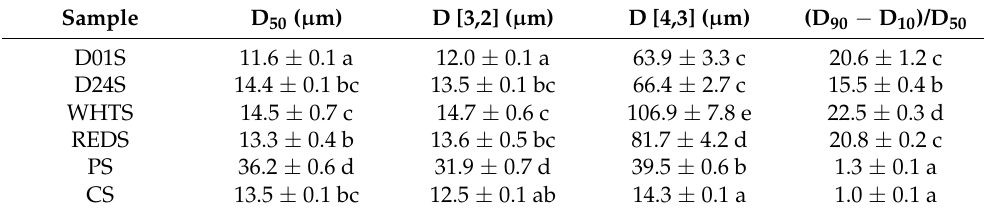
Table 1. Particle size distribution of four cultivars of anchote, potato, and cassava starches.